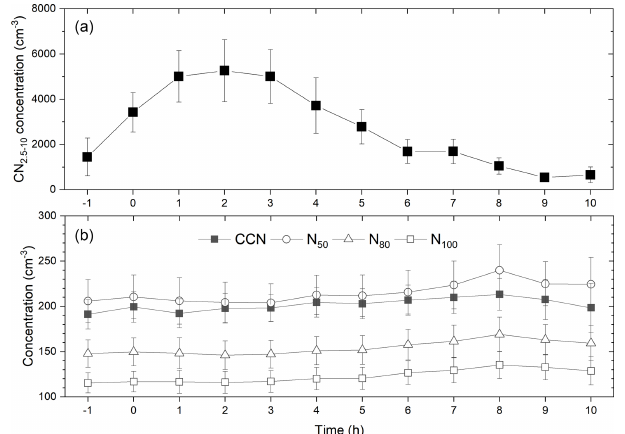
Figure 5. Variation in (a) CN 2 . 5 − 10 concentrations measured using CPC and (b) CCN concentrations measured with a CCN counter and number concentrations calculated using SMPS data with time. N 50 , N 80 and N 100 represent number concentrations of particles lager than 50, 80 and 100nm in diameter, respectively. The zero in the x axis indicates the start time of the NPF